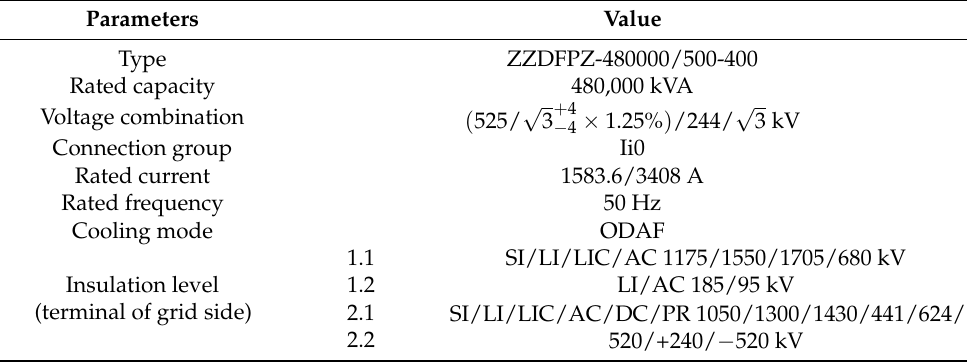
Figure 2. The operating principle of the vibrational measurement system. Table 1. Test parameters of the converter transformer in the converter station.